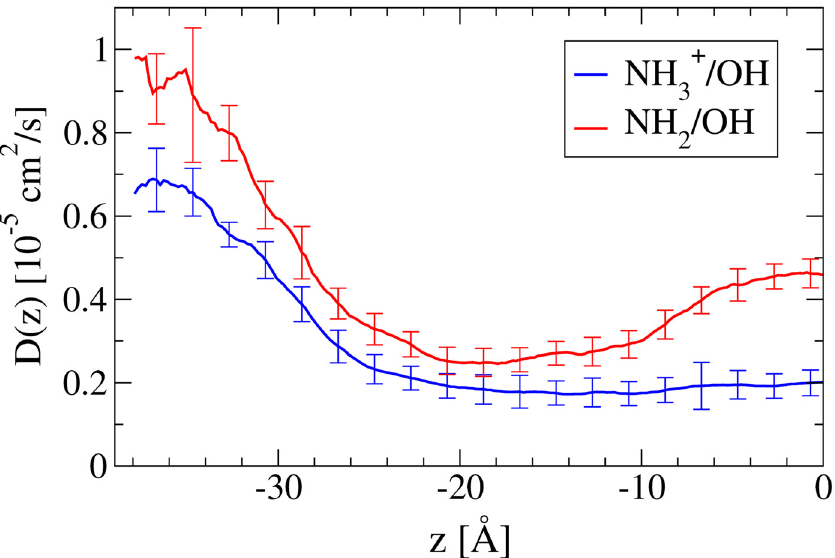
Fig 7. The position dependent diffusion coefficient, D(z), of tyr (NH 2 /OH) and tyr + ( NH 3 þ = OH ) across a POPC bilayer with the bilayer center at z = 0. The diffusion for tyr + remains relatively constant once inside the bilayer. This is likely due to a water channel being created in the POPC through a strong interaction of water with the NH 3 þ group. The water follows tyr + through and reduces its mobility while keeping it in a consistent environment. The tyr permeates without water and has mobility characteristics that correlate strongly with the bilayer density, including a densely packed region near the head groups and an area of high free volume at the center of the bilayer where the hydrocarbon tails